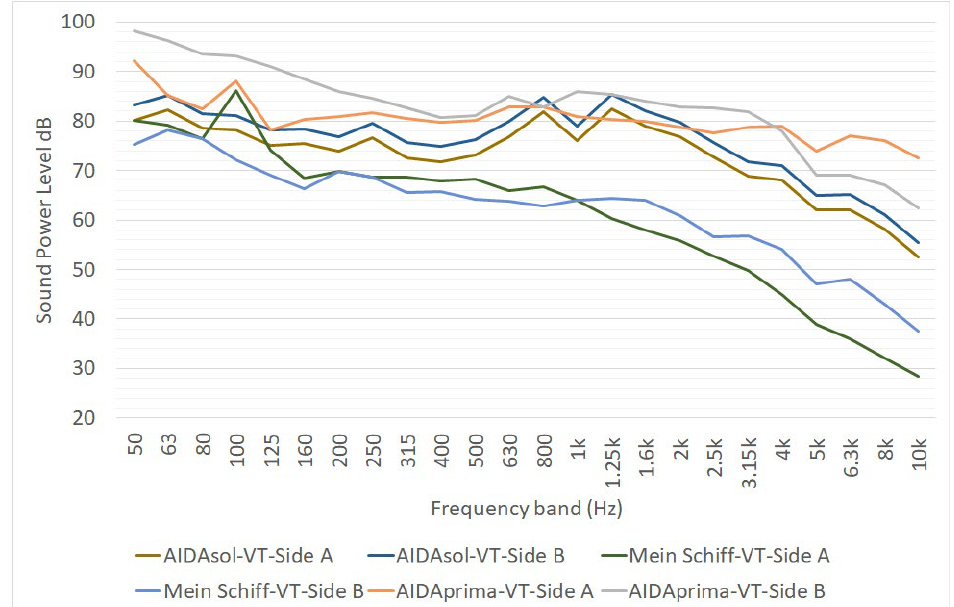
Figure 9. One-third octave sound power spectra of ventilation openings on the two sides of three vessels, as reported in [20]. L W is expressed in dB for point sources, in dB/m for linear sources and in dB/m 2 for area sources.